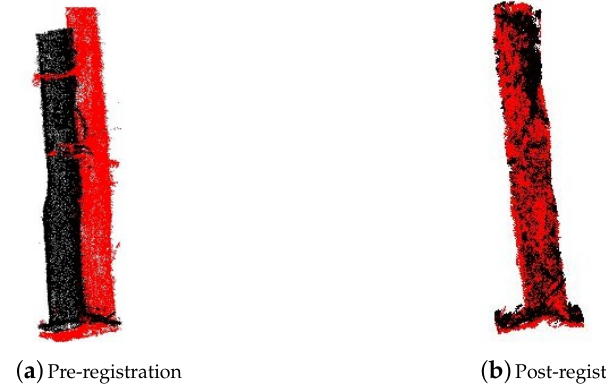
Figure A2. Illustration of co-registration using a tree trunk from the removal plot. Black: Pre-cut data and Red: Post-cut data.